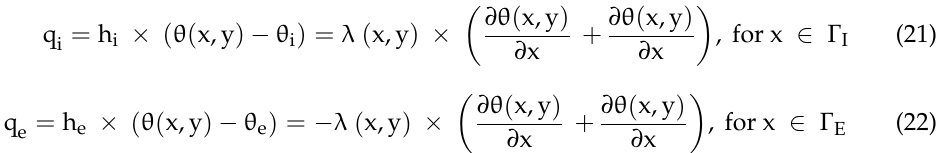
Figure 8. Model of a fragment of a structure with a generated mesh. The Newtonian boundary conditions, i.e., the convection at the boundary with the outside and inside air, are determined by the relations [30]: